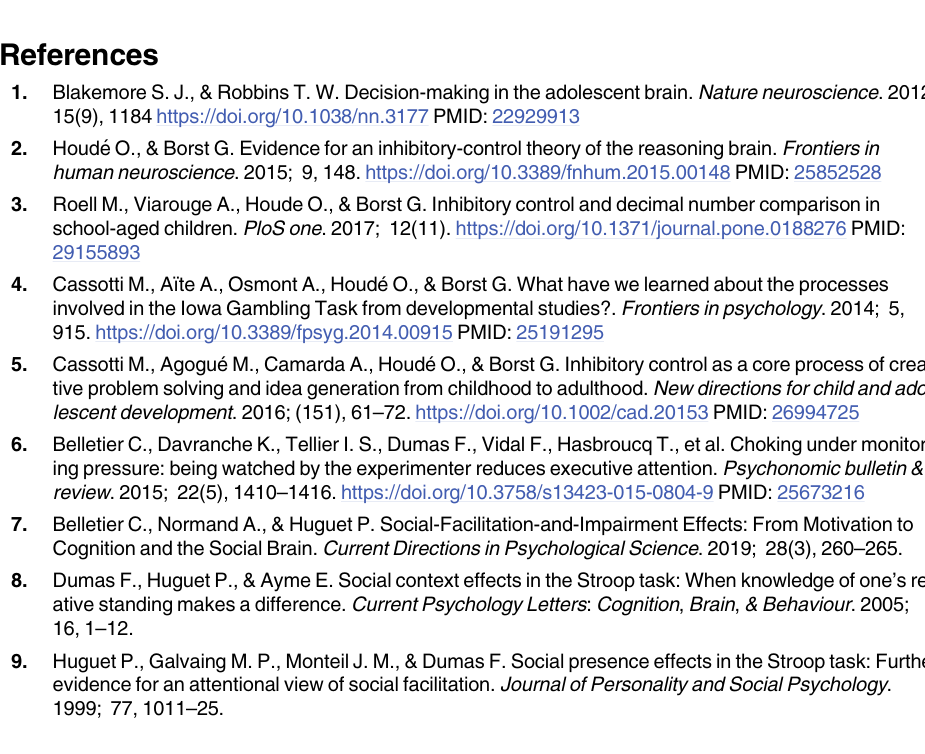
Experiment 2 for each age group under each social condition. The error bars represent the standard error of the